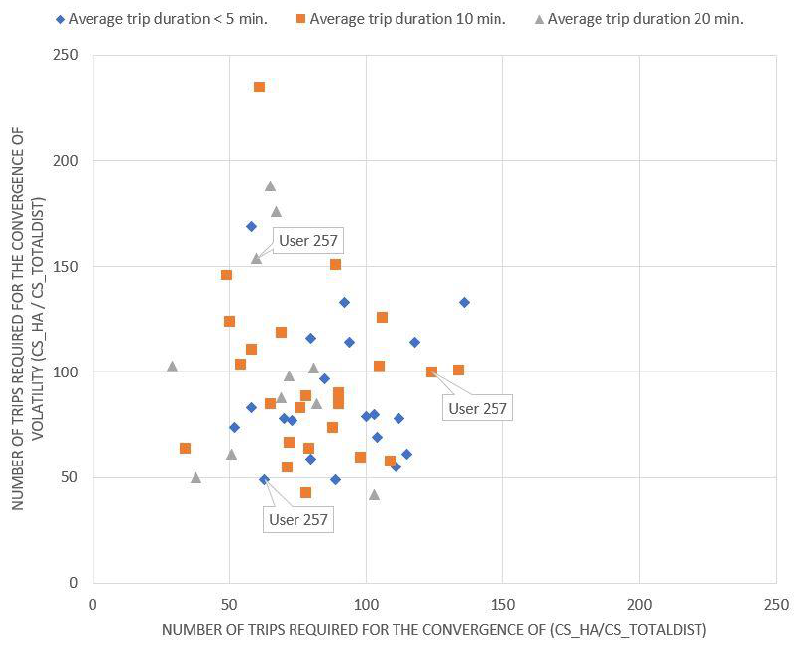
Figure 1. Minimum number of trips required for the number of harsh acceleration events per km rate to converge. Sensors 2020 , 20 , x